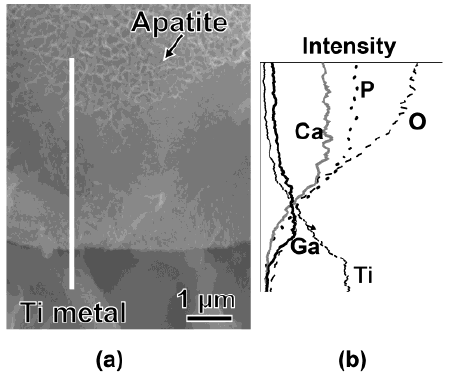
Figure 9. ( a ) FE-SEM photographs and ( b ) EDX line analysis of cross sections of Ti soaked in SBF for 7 days after 100Ga, heat and water treatments following the NaOH treatment. EDX line analysis was performed along with white line in the photographs.